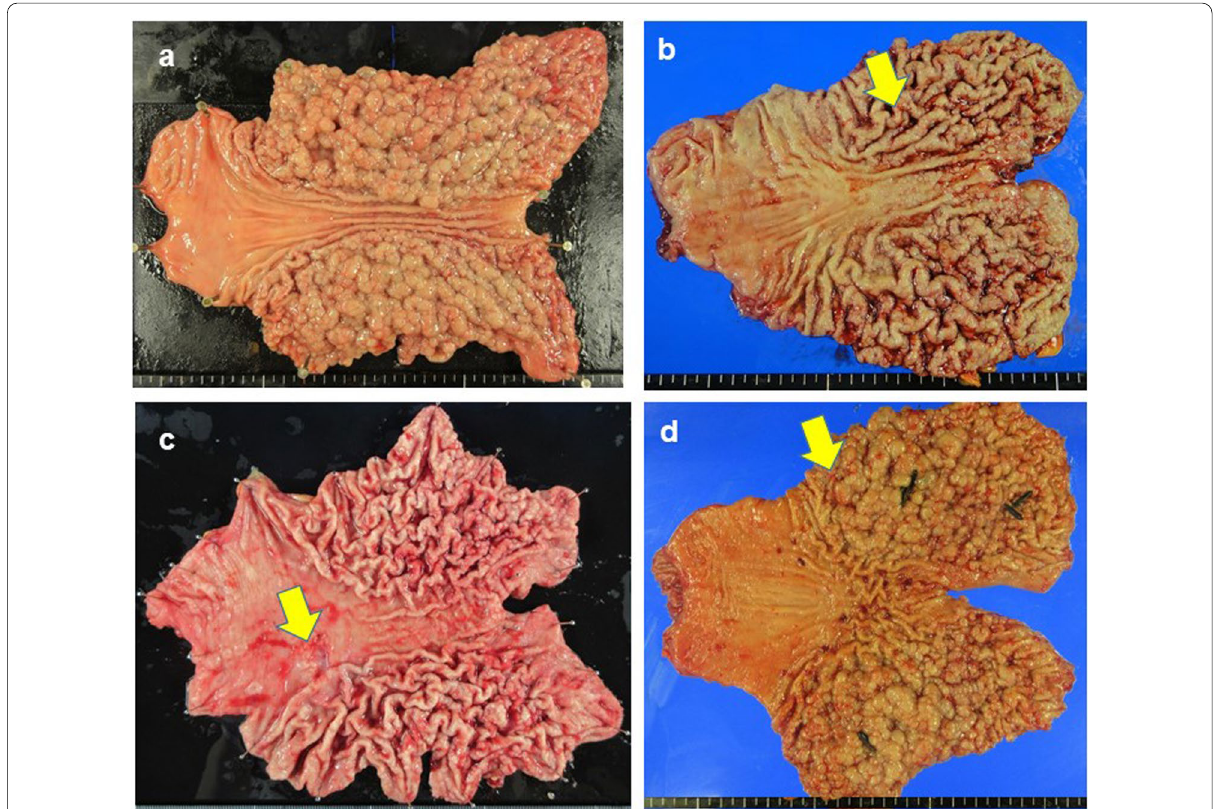
Fig. 2 Surgical specimen. a Case 1; b Case 2, cancer-suspected lesion (arrow); c Case 3, cancer lesion (arrow); d Case 4, cancer-suspected lesion